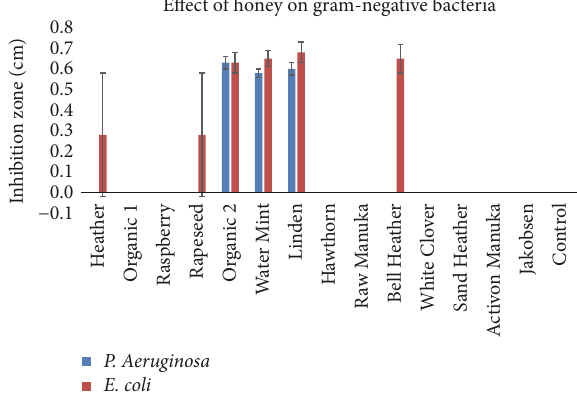
Figure 3: Effect of different floral sources of honey on growth of gram-negative bacteria (mean ± SD; n = 2).